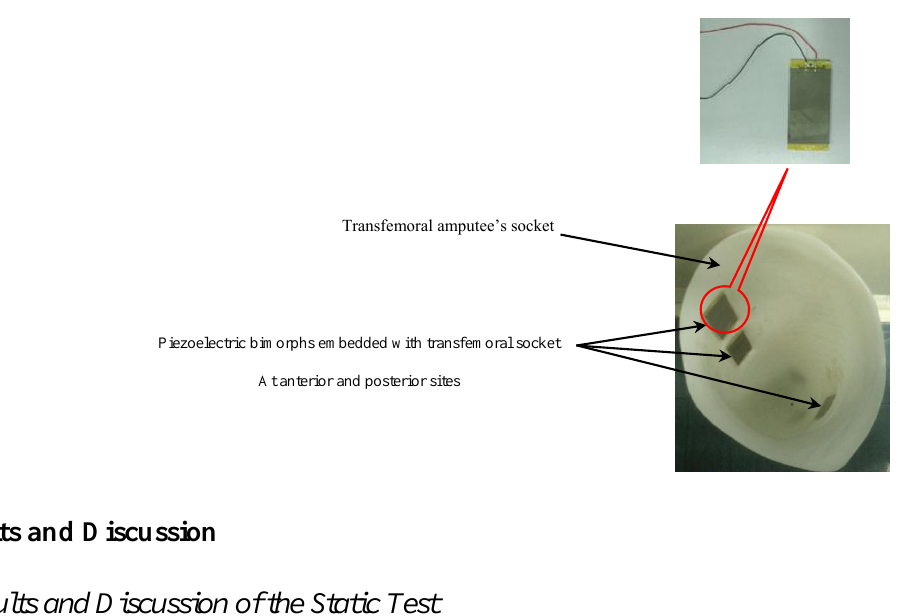
Figure 5. Piezoelectric bimorph sensors embedded to the transfemoral amputee’s socket.